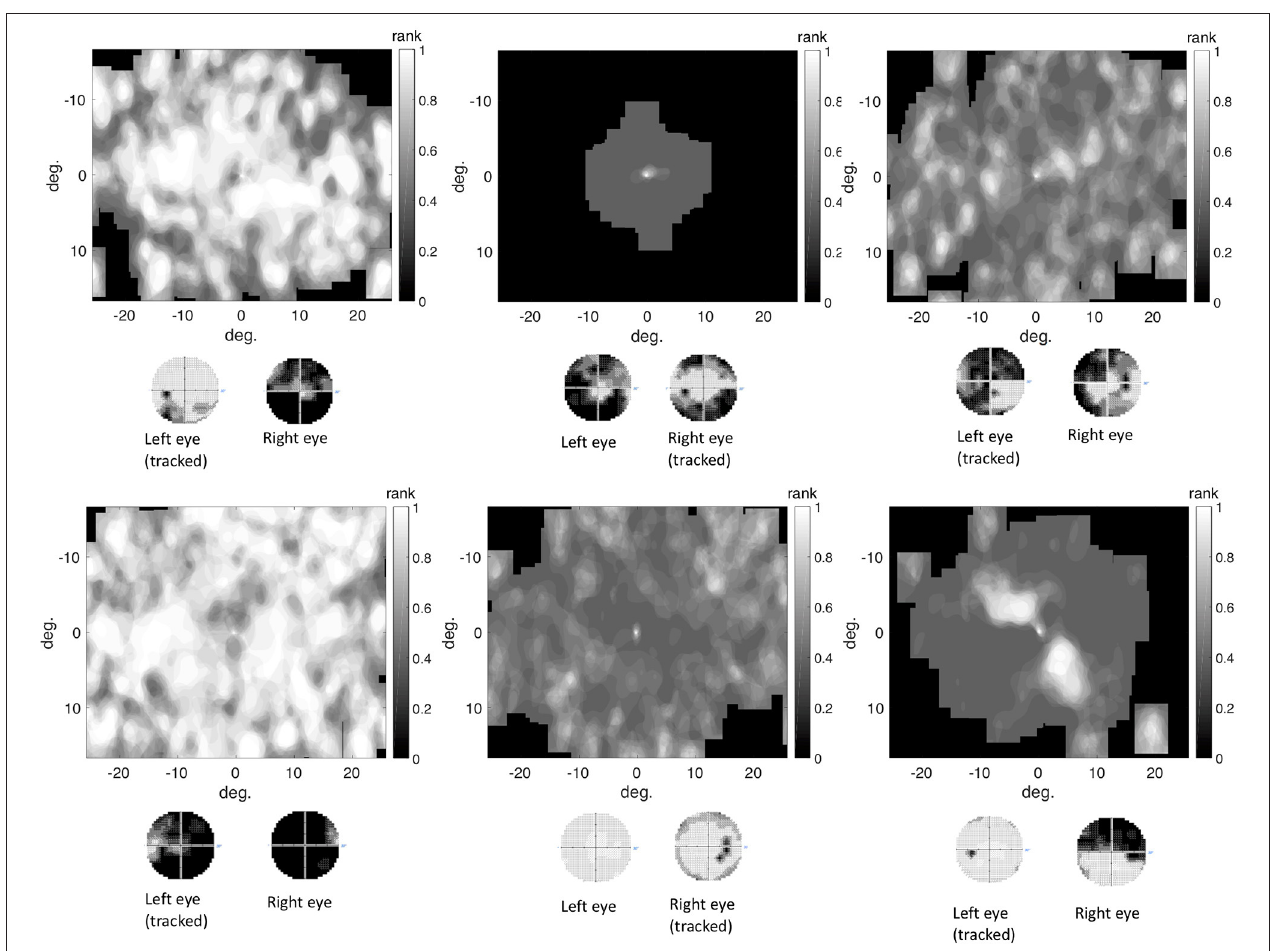
FIGURE 7 | The differential fixation maps of the same patients. A value higher (lower) than 0.5 means that the patient made more (less) eye movements toward a part of the visual field than the control group.